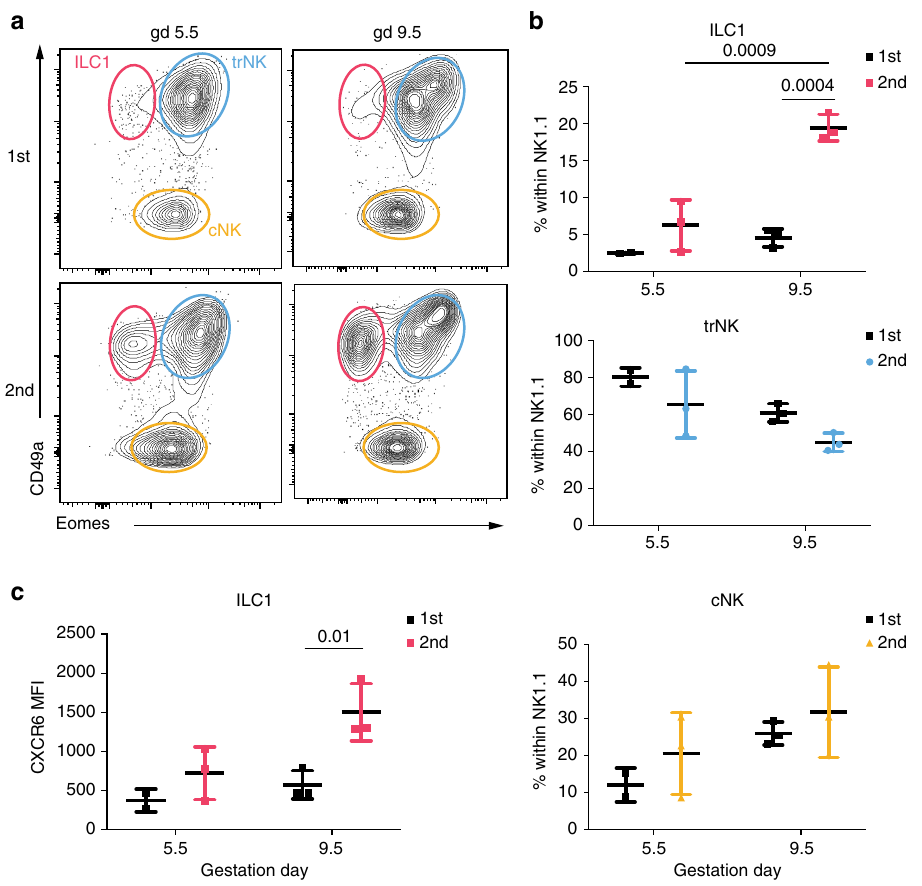
Fig. 5 Eomes − CD49a + CXCR6 + g1 ILCs expand speci fi cally in second gestation. a Representative plots showing distribution of g1 ILCs (gated as in Fig. 1a) at gd 5.5 and gd 9.5 in fi rst (top row) and second (bottom row) pregnancy. Data representative of two or three independent samples and three independent experiments. b Quanti fi cation of percentages of ILC1, trNK and cNK presented in a in fi rst and second pregnancy at gd 5.5 and gd 9.5. Statistical signi fi cance was evaluated by two-way ANOVA with multiple comparisons correction. Error bars represent mean ± SD. c Mean fl uorescence intensity of CXCR6 on ILC1s in fi rst and second pregnancy at gd 5.5 and gd 9.5 Statistical signi fi cance was evaluated by two-way ANOVA with multiple comparisons correction. Error bars represent